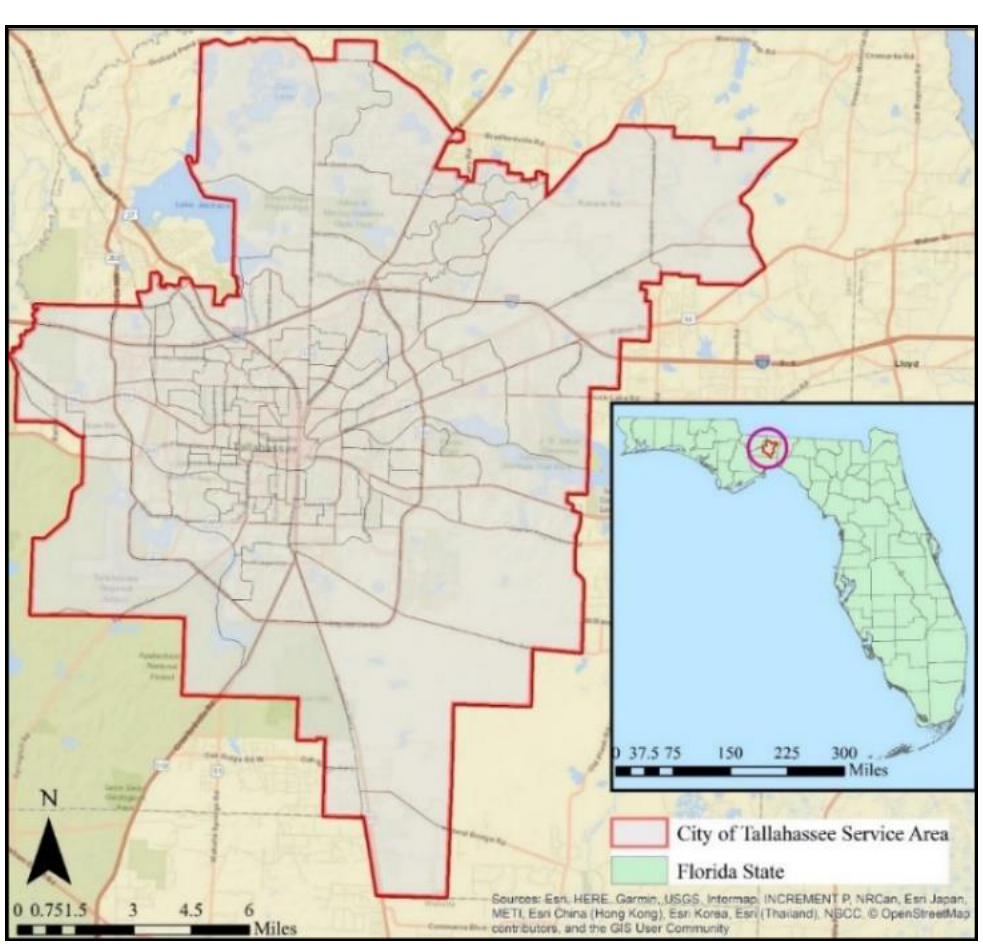
Figure 1. Study area.